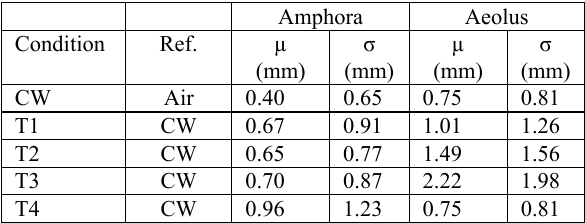
Table 4.: Geometrical error (mean µ and standard deviation σ )